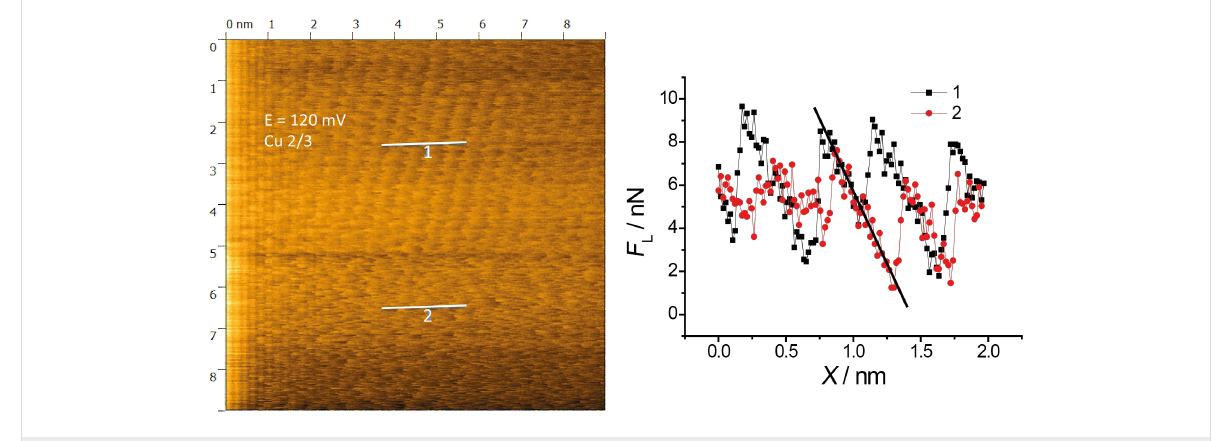
Figure 6: Stick–slip atomic resolution and cross section analysis for a potential jump from 0 mV (full Cu adlayer) to 120 mV (2/3 Cu adlayer), cross section along the two short horizontal lines F N = 45 nN; scan rate 275 nm/s.